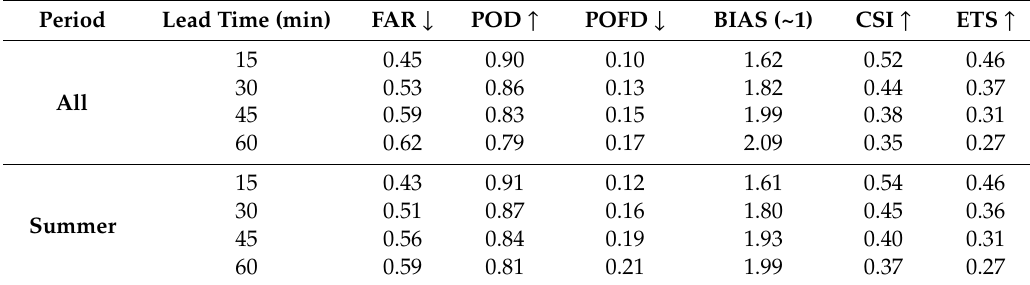
Table 2. Binary statistics from PredRNN ++ model applied to all test data, for each lead time (in minutes): False Alarm Rate (FAR); Probability of Detection (POD); Probability of False Detection (POFD); the BIAS score; Critical Success Index (CSI), and Equitable Threat Score (ETS). All statistics were computed using thresholds of 1 dBZ for predicted and observed